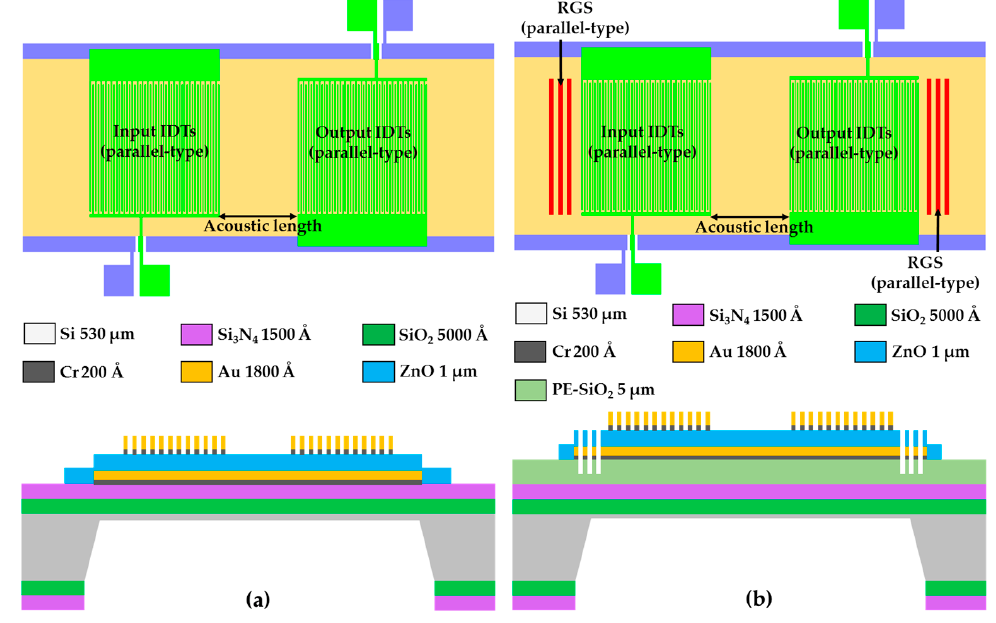
Figure 1. Layout diagram and cross-sectional structure of two conventional FPW transducers; ( a ) without, and ( b ) with a parallel-type Si-grooved RGS.